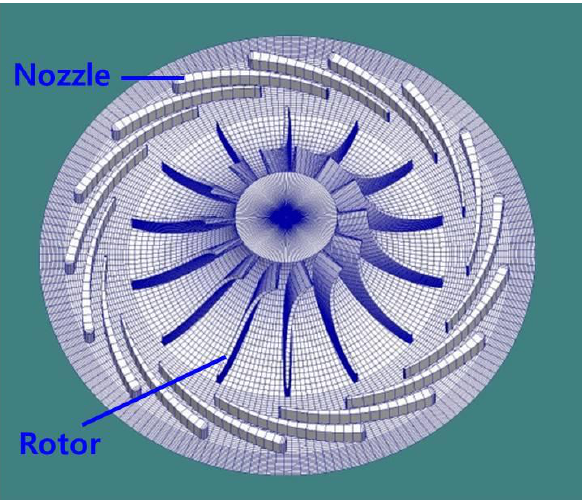
Figure 4. Performance prediction curves from meanline analysis: ( a ) expansion ratio vs. mass flow rate; ( b ) expansion ratio vs. efficiency; ( c ) expansion ratio vs. power; ( d ) expansion ratio vs. expander outlet temperature.